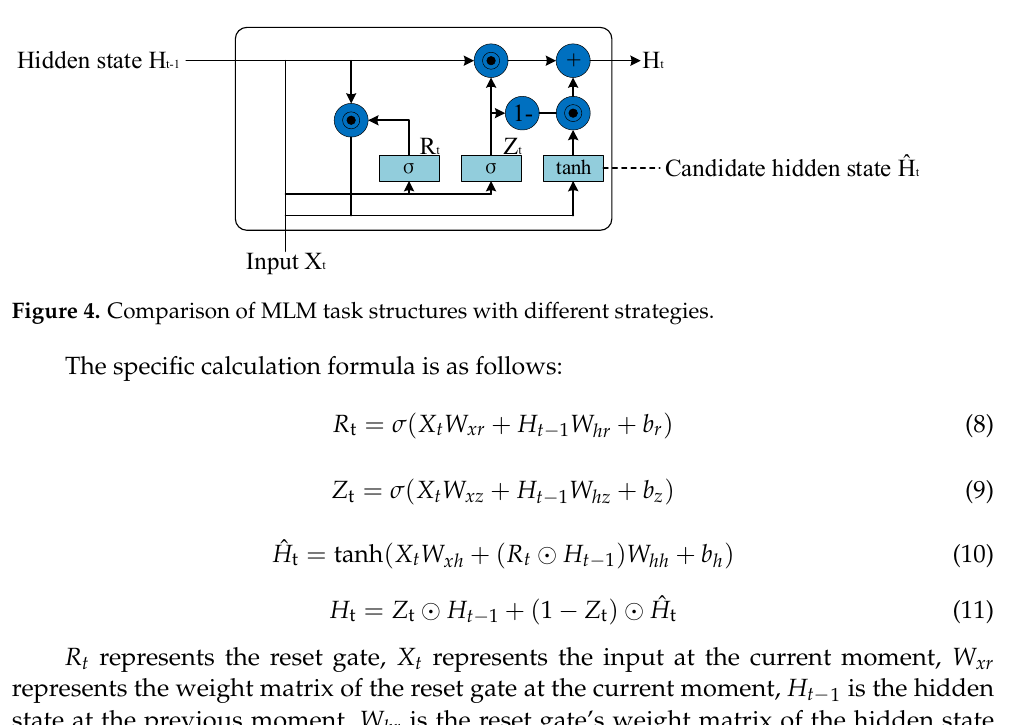
(c) MLM on Ernie-Gram × L × L × L Figure 3. Comparison of MLM task structures with di ff erent strategies. 3.2.4. BiGRU Module BiGRU is a neural network model composed of forward and reverse GRUs. The GRU consists of two control units: reset gate unit R t and update gate unit Z t . The reset gate is